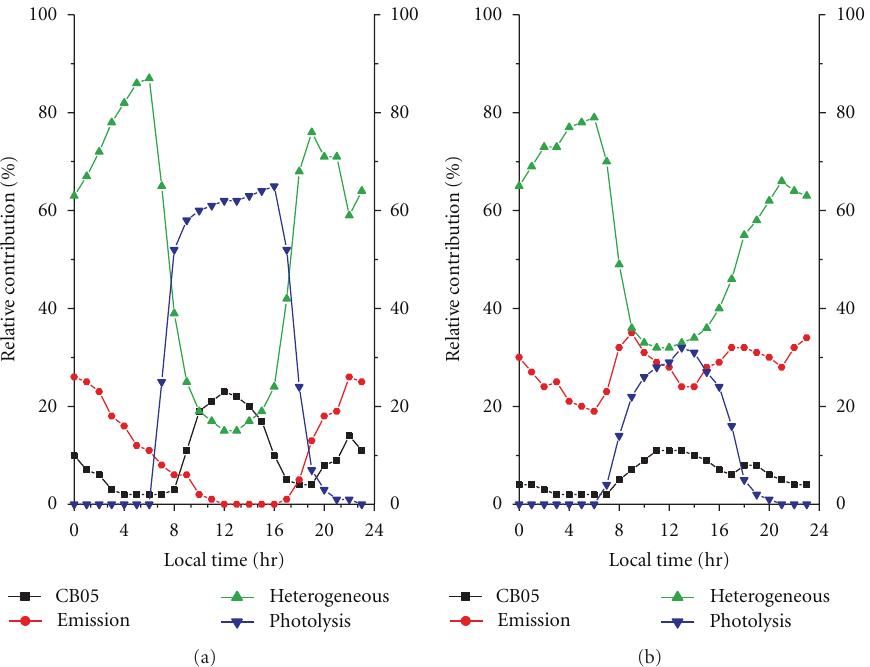
Figure 6: Average relative contributions of di ff erent HONO sources to predicted ground HONO concentration at (a) Xinken and (b)